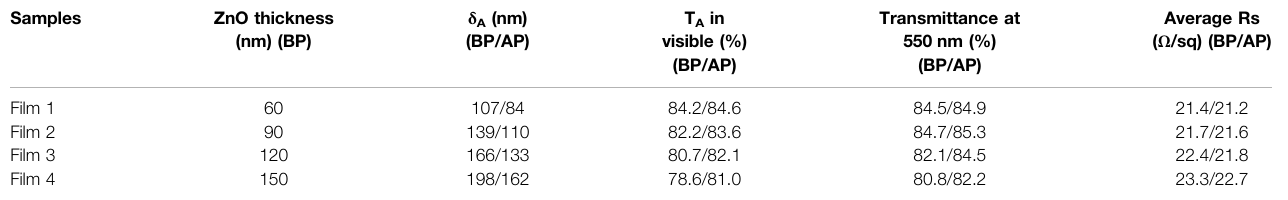
TABLE 1 | Thickness, transmittance, and sheet resistance of AgNWs/ZnO fi lms in PM6:Y6 devices before polishing and after polishing.